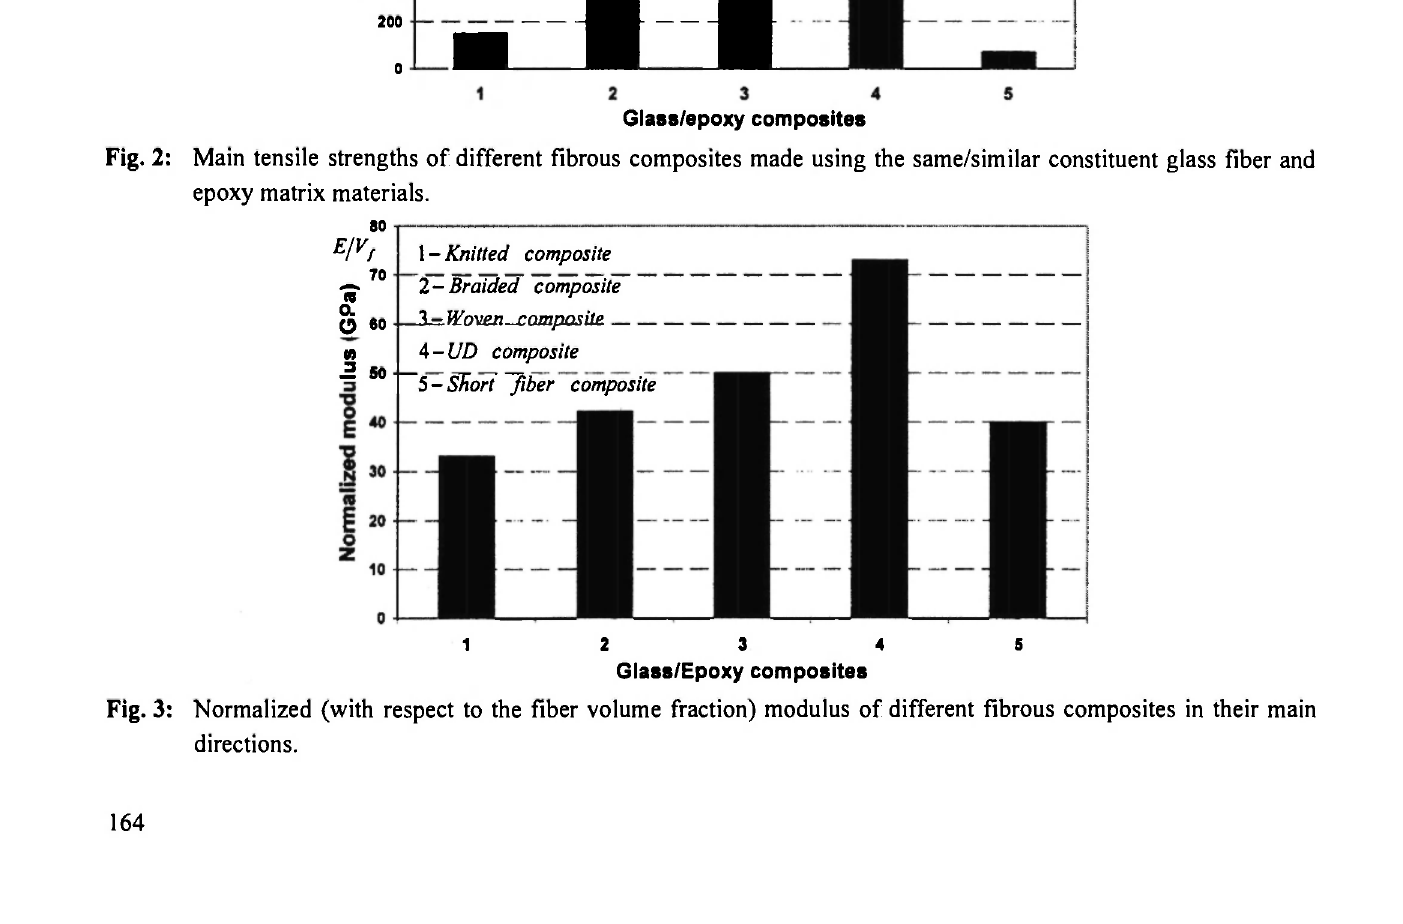
Fig. 2: Main tensile strengths of different fibrous composites made using the same/similar constituent glass fiber and epoxy matrix materials.